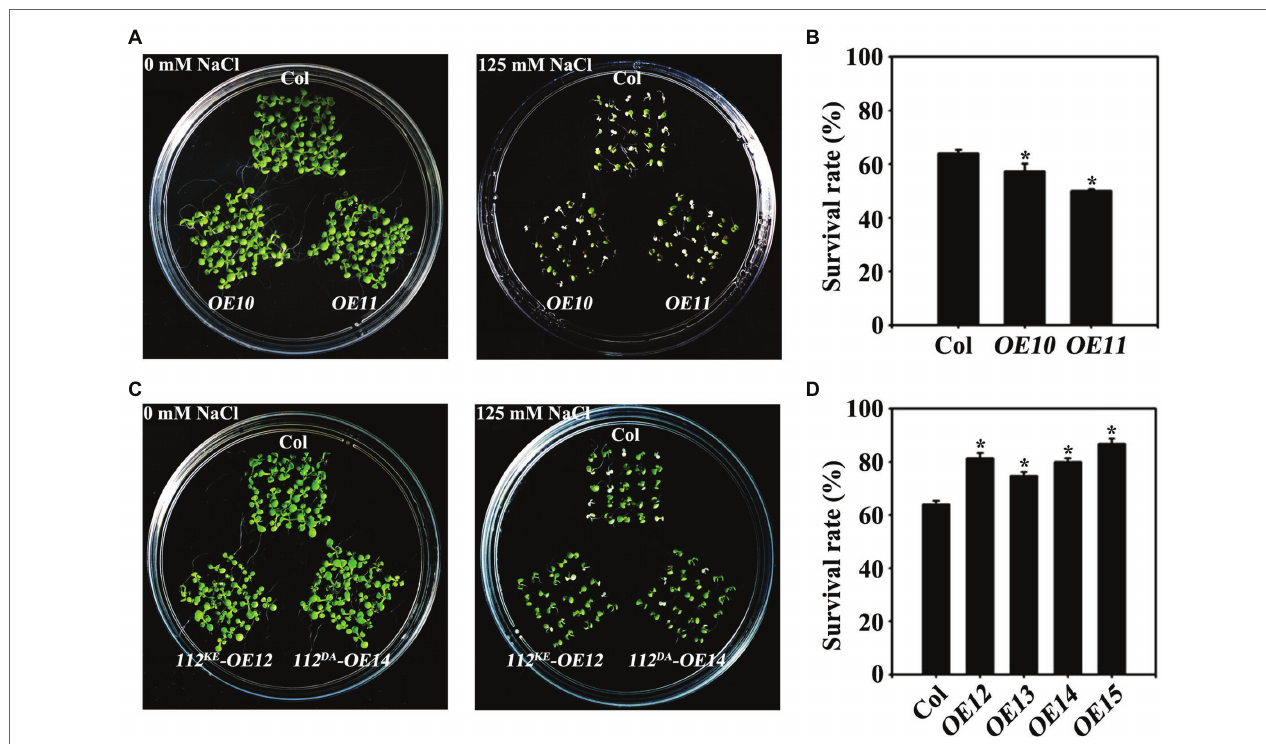
FIGURE 5 | OsWAK112 mediates salt sensitivity depending on its kinase activity. Arabidopsis plants overexpressing OsWAK112 showed hypersensitivity to salt compared with Col (A,B) , while A rabidopsis plants overexpressing OsWAK112 K678E and OsWAK112 D794A showed hyposensitivity to salt compared with Col (C,D) . The indicated seedlings were grown on 0.5 × MS medium supplemented with or without 125 mM NaCl for 10 days, and the salt survival rate was calculated. OE10 and OE11 represent two independent 35S:OsWAK112-Myc/Col transgenic lines. OE12 and OE13 represent two independent 35S:OsWAK112 K678E -Myc/Col transgenic lines. OE14 and OE15 represent two independent 35S:OsWAK112 D794A -Myc/Col transgenic lines. The experiments were repeated three times. Each data point represents the mean ± SE ( n ≥ 25). Asterisks indicate a difference relative to Col (Student’s t -test, * p < 0.05) in (B-D)